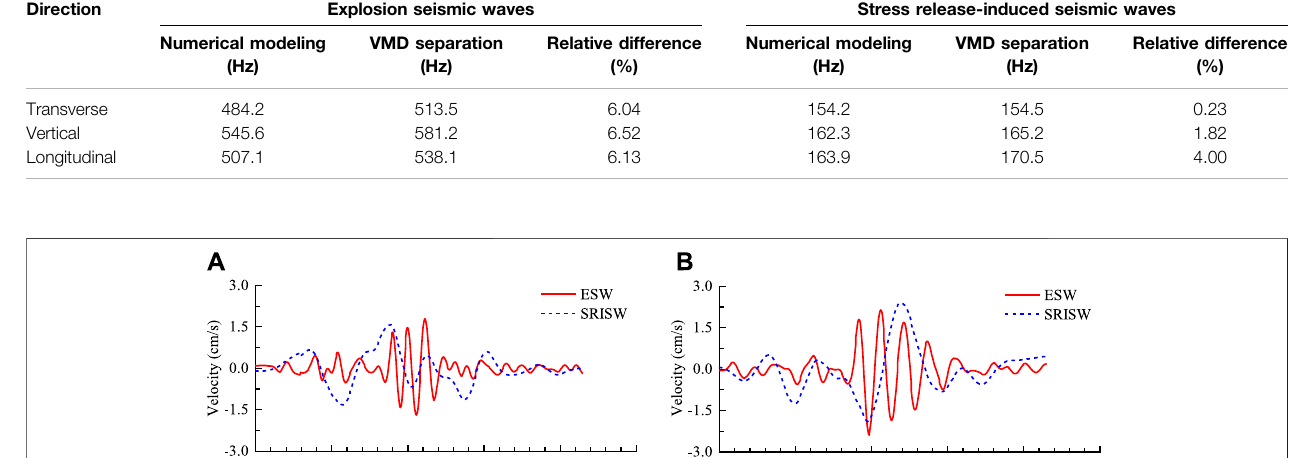
TABLE 2 | Center frequency of the respective seismic waves obtained by the numerical modeling and the VMD separation. Direction